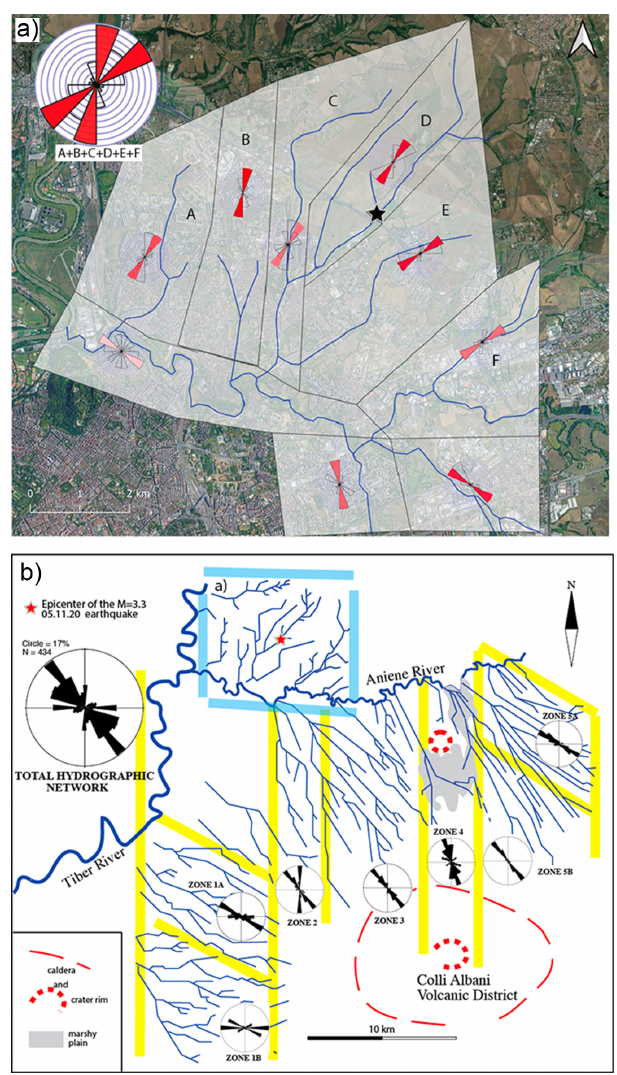
Figure 5. (a) The result of the streambed direction analysis per- formed in this work within the hydrographic basin including the epicenter area of the 11 May event (pale blue borders in b ) is compared with that performed in the southeastern Roman area, between the Tiber, the Aniene and the Colli Albani (b) (Marra, 2001). Yellow lines border the different sectors of the analyzed drainage basins. Analysis in the historical city center was hin- dered by the occurrence of a widespread anthropic cover. Basemap from QGIS QuickMapServices (available under Creative Commons Attribution-ShareAlike 3.0 licence (CC BY-SA) at https://plugins. qgis.org/plugins/quick_map_services/, last access: 23 July